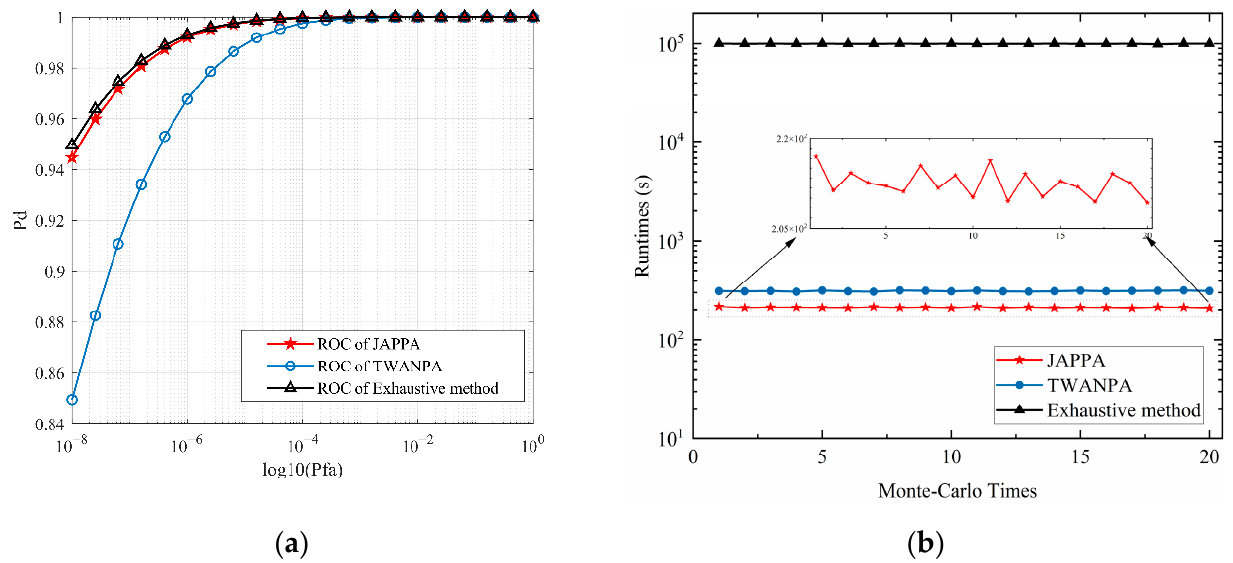
Figure 11. Performance comparison of TWANPA, the exhaustive search, and the JAPPA: ( a ) average ROC curves; ( b ) runtime.